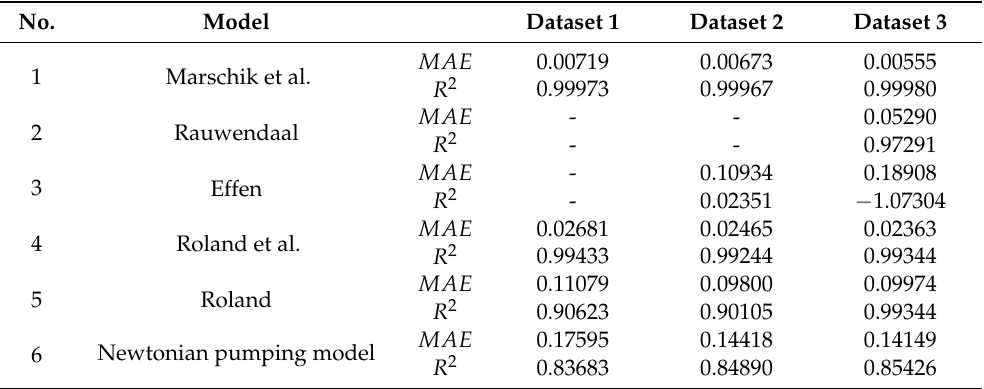
Table 8. Quality measures of the approximations: mean absolute error ( MAE ) and coefficient of determination ( R 2